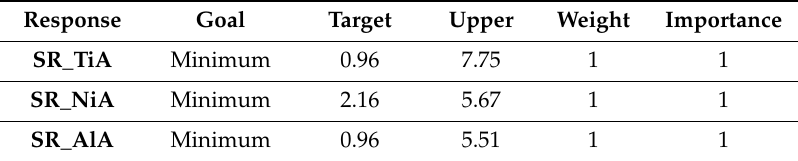
Table 6. Optimization goal for TiA, NiA, and AlA.